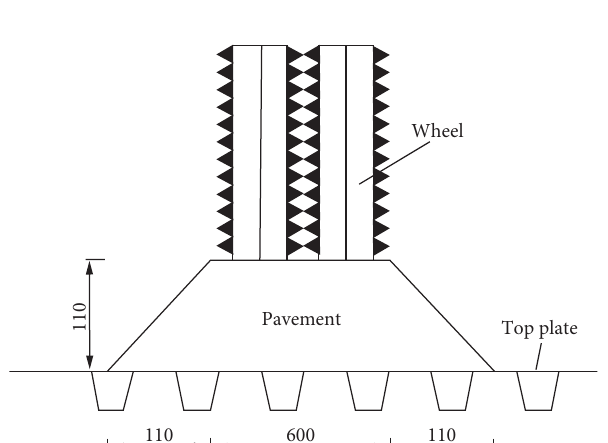
Figure 15: Multiscale model of full-bridge.